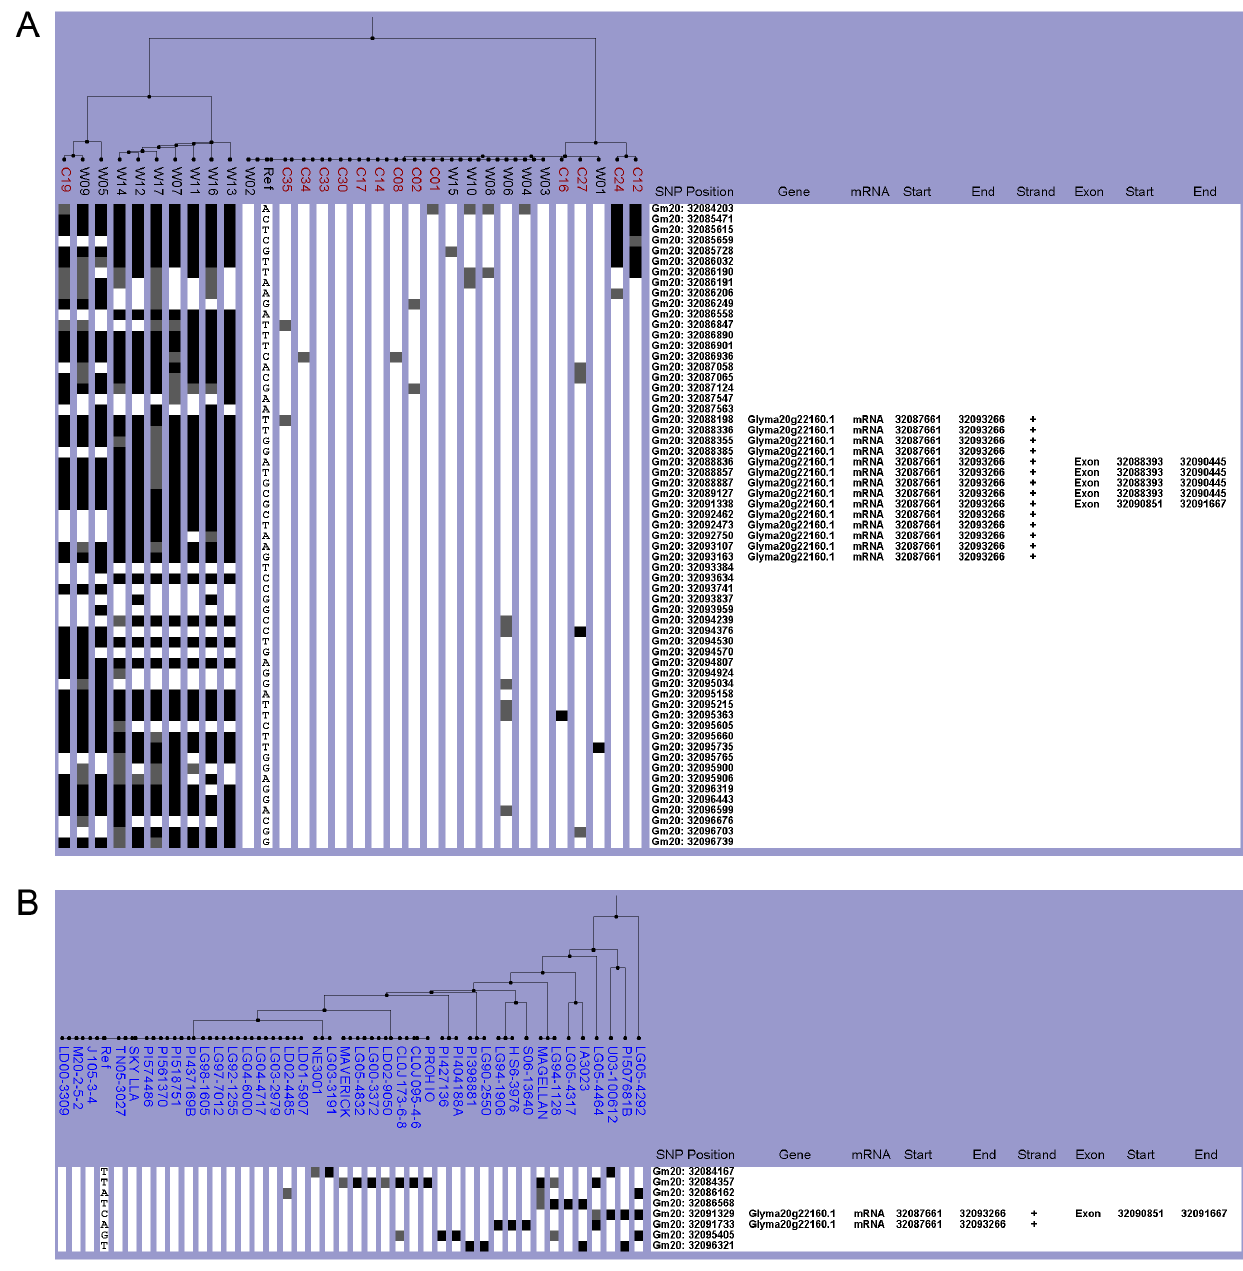
Figure 5. Haplotype analysis of the E4 gene region. The SNPViz clustering pictorial displayed the SNPs in a 12.6-kb region on chromosome 20, which included Glyma20g22160. Nucleotide polymorphisms were examined in A) the wild (black) and cultivated (red) lines from the Chinese collection and B) the NAM parents (blue). Details about the SNPViz clustering pictorial were described in the Figure 1 legend.